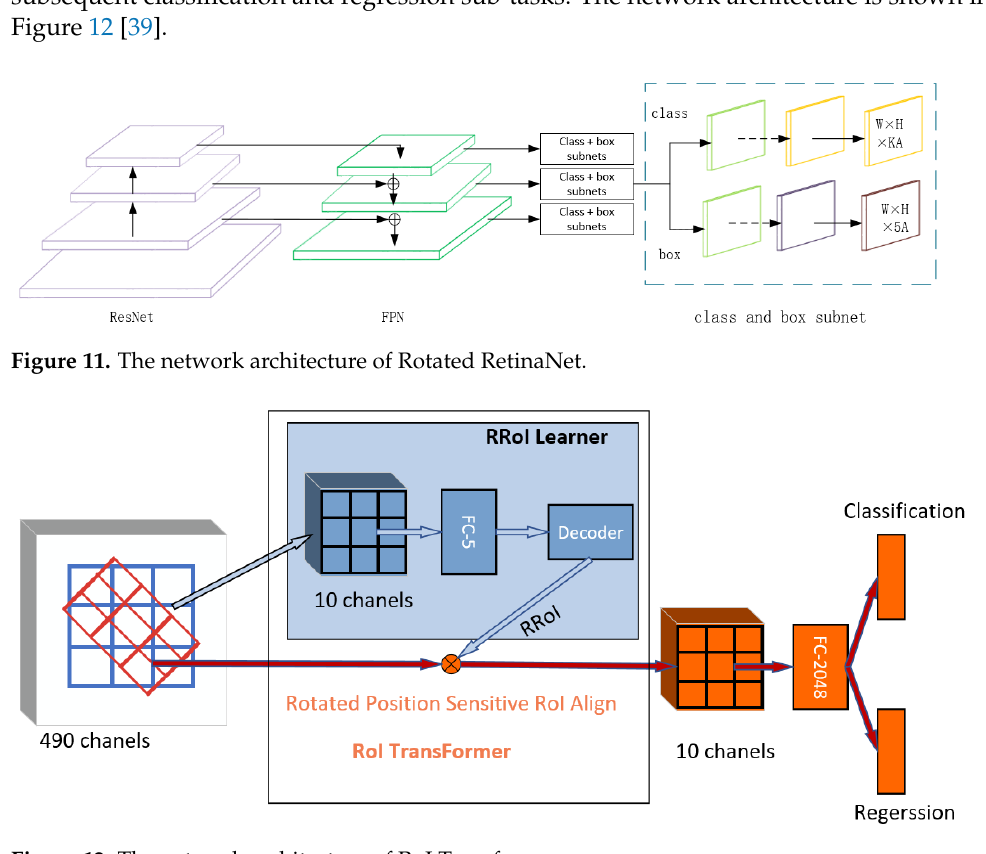
Figure 12. The network architecture of RoI Transformer.